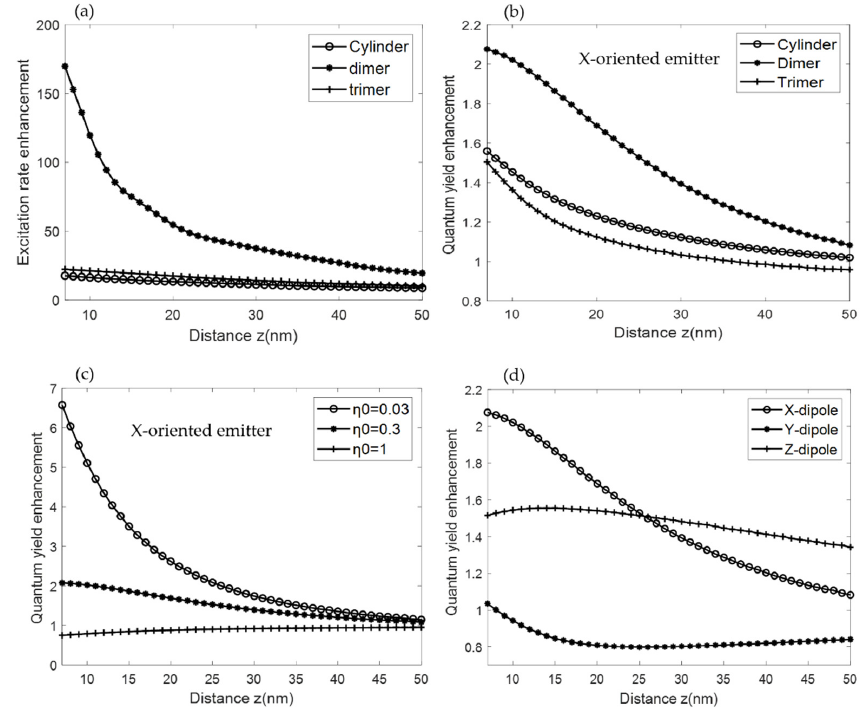
Figure 7. Excitation and emission enhancement as a function of distance z (nm). ( a ) Excitation en- hancement and ( b ) quantum yield enhancement variation of a fluorophore with an x -orientation and intrinsic quantum yield η 0 = 0.3 when coupled to different geometries. ( c ) Quantum yield en- hancement variation with distance z (nm) for fluorophores having intrinsic quantum yield η 0 = 0.03, 0.3, 1 when coupled to dimer nanoantenna. ( d ) Quantum yield enhancement variation of a fluoro- phore with X , Y , and Z orientation with an intrinsic quantum yield η 0 = 0.3 coupled to dimer nano-